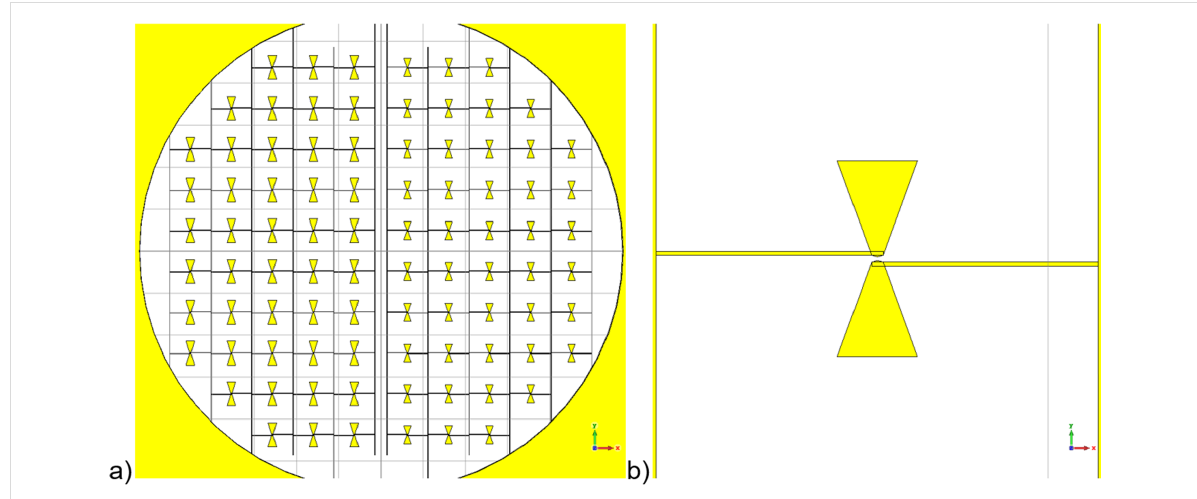
Figure 5: a) Receiving cell array based on bow-tie antennas; half of the 7 mm plate on the left are 210 GHz and on the right 240 GHz frequency chan- nels. b) A receiving system cell based on a bow-tie antenna.